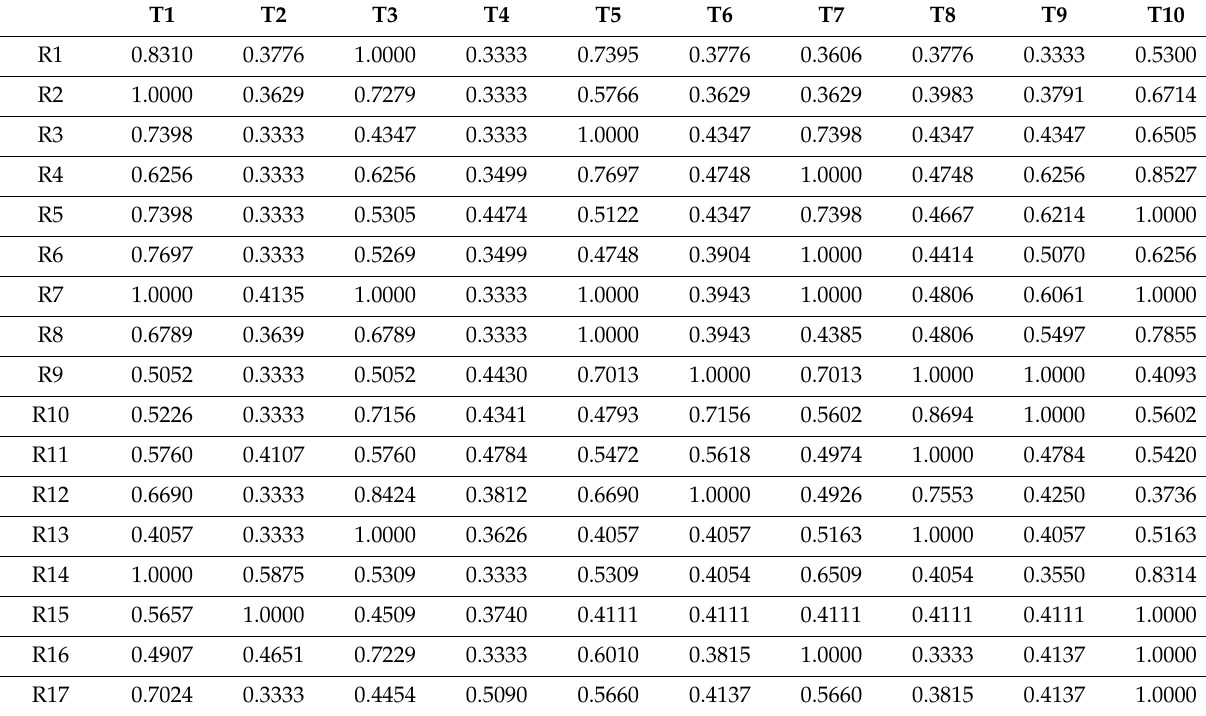
Table 6. Grey relational coe ffi